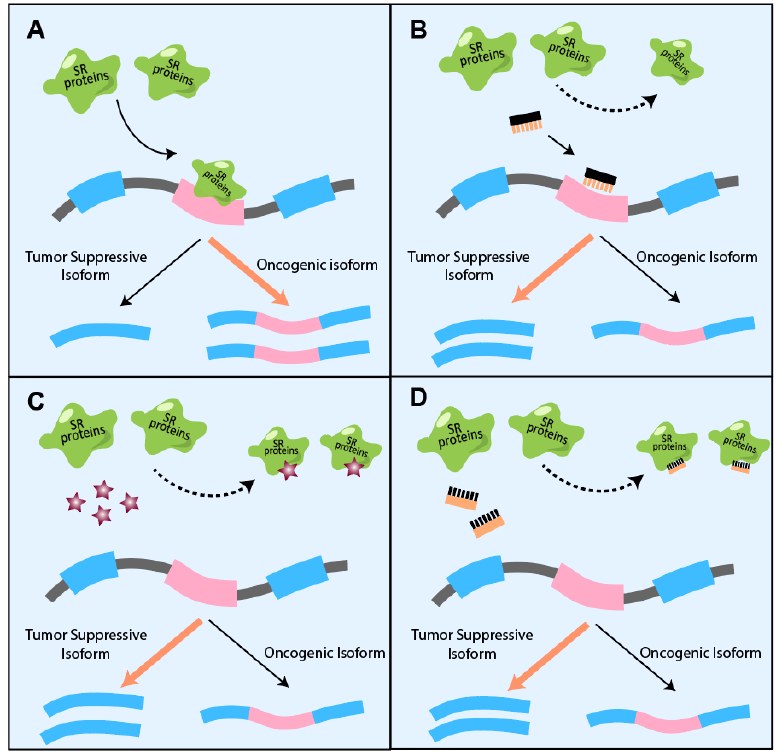
Figure 6. Strategies for correcting SR-protein-mediated aberrant alternative splicing. ( A ) Elevated SR proteins alter RNA splicing. ( B – D ) Principles for targeting SR proteins induced aberrant RNA splicing in cancer. ( B ) Antisense oligonucleotides bind to RNA and block SR proteins’ effect on target RNA alternative splicing. ( C ) Small molecular inhibitors bind to RRM domain of SR proteins and inhibit RNA binding. Stars represent small molecular inhibitors. ( D ) Decoy oligonucleotides composed of SR protein binding sequence bind to SR proteins and block their access to the target RNA.